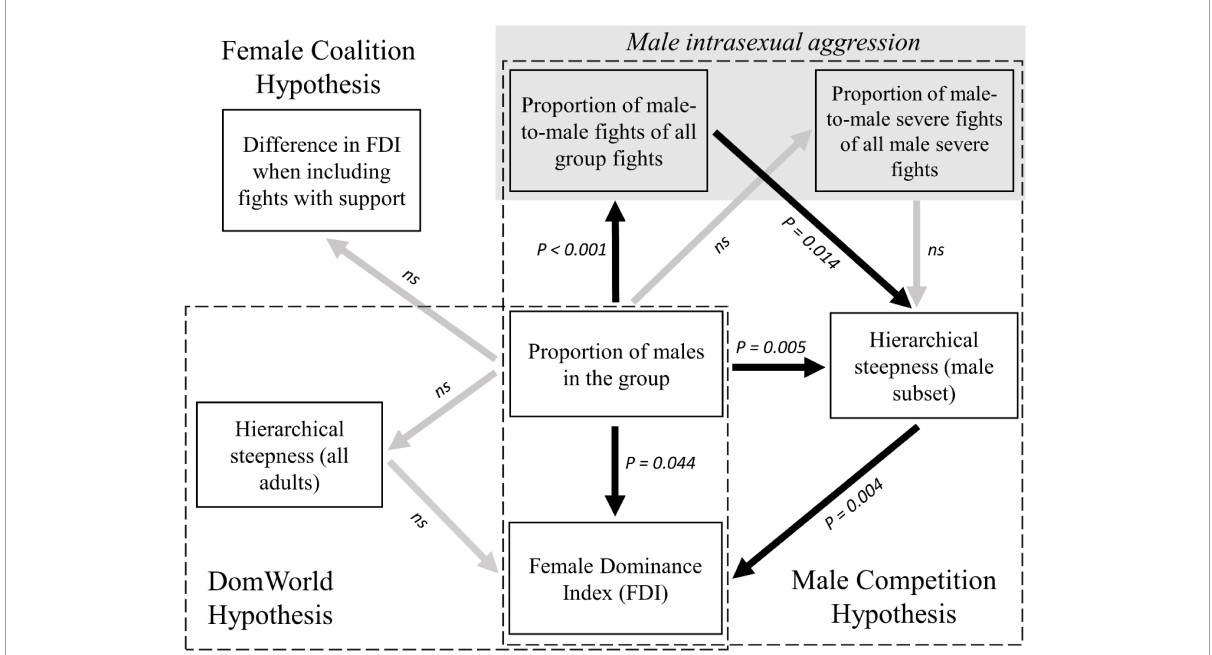
FIGURE3 Summary of correlations related to the degree of female dominance (i.e., Female Dominance Index, FDI) in vervet monkeys. Correlations are represented as arrows pointing from the response variable to the explanatory variable. The statistical significance of each correlation is noted next to the arrow (with not significant values noted as ns ). Significant correlations are noted as black arrows, while non-significant correlations as gray arrows. All significant correlations are